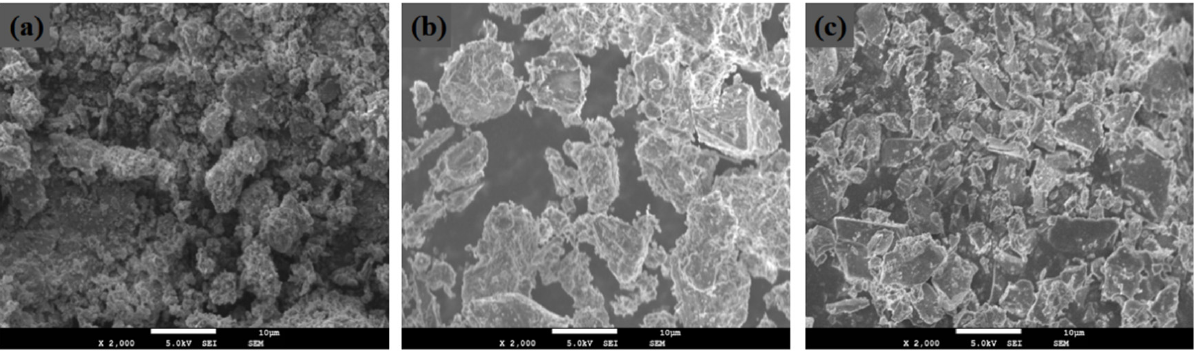
Figure 4. SEM images of the ( a ) OSR, ( b ) SS and ( c ) GGBS.